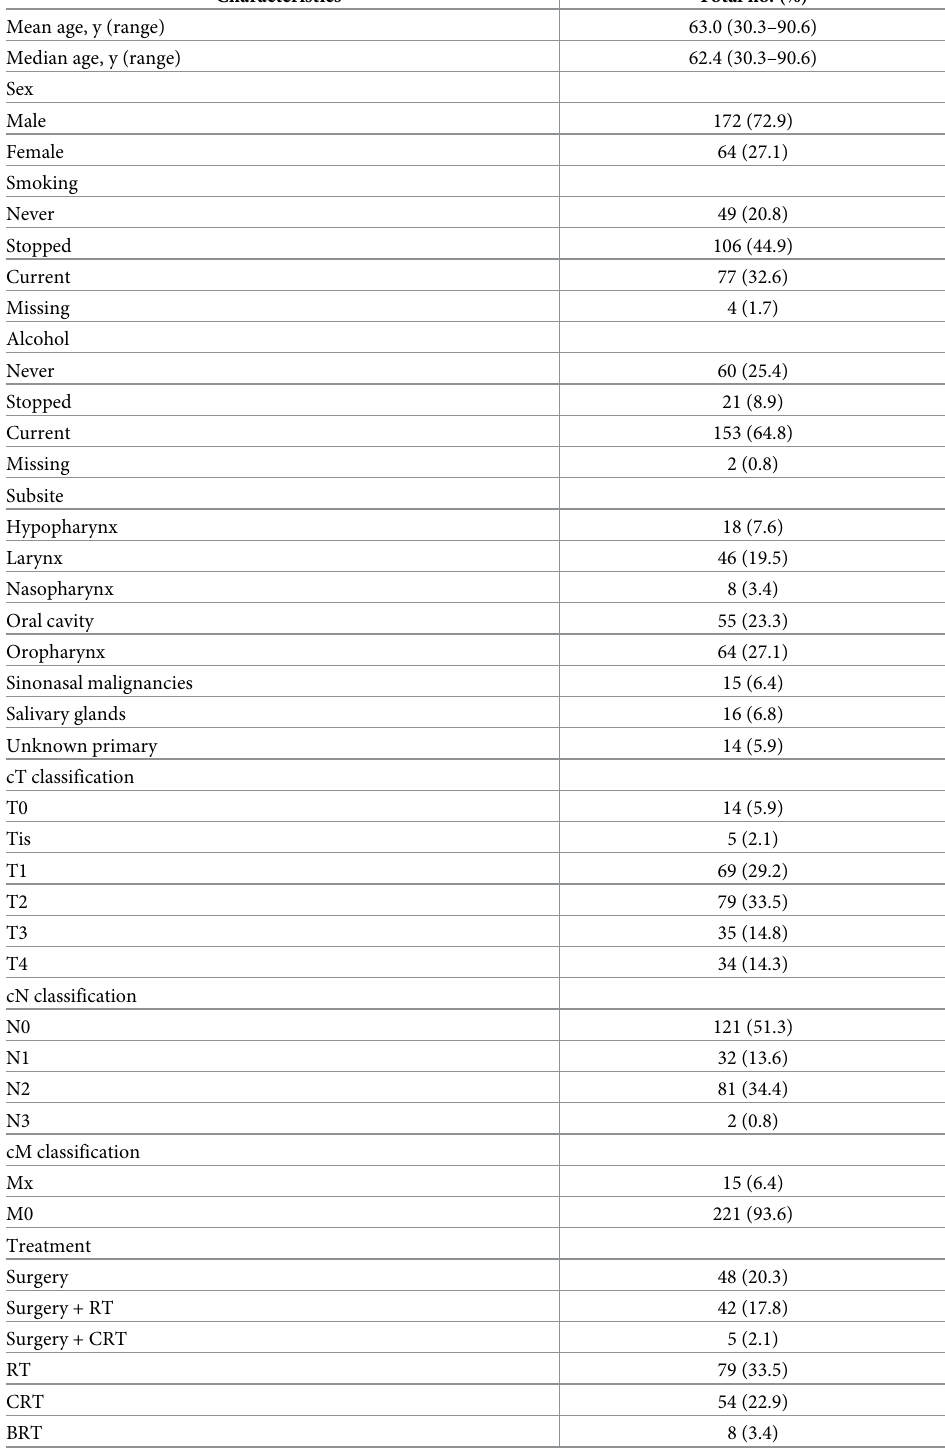
Table 1. Patient, tumor and treatment characteristics. Tumors were staged according to cTNM clinical classifica- tion of the Union for International Cancer Control (UICC) (2009, 7 th edition) [24].